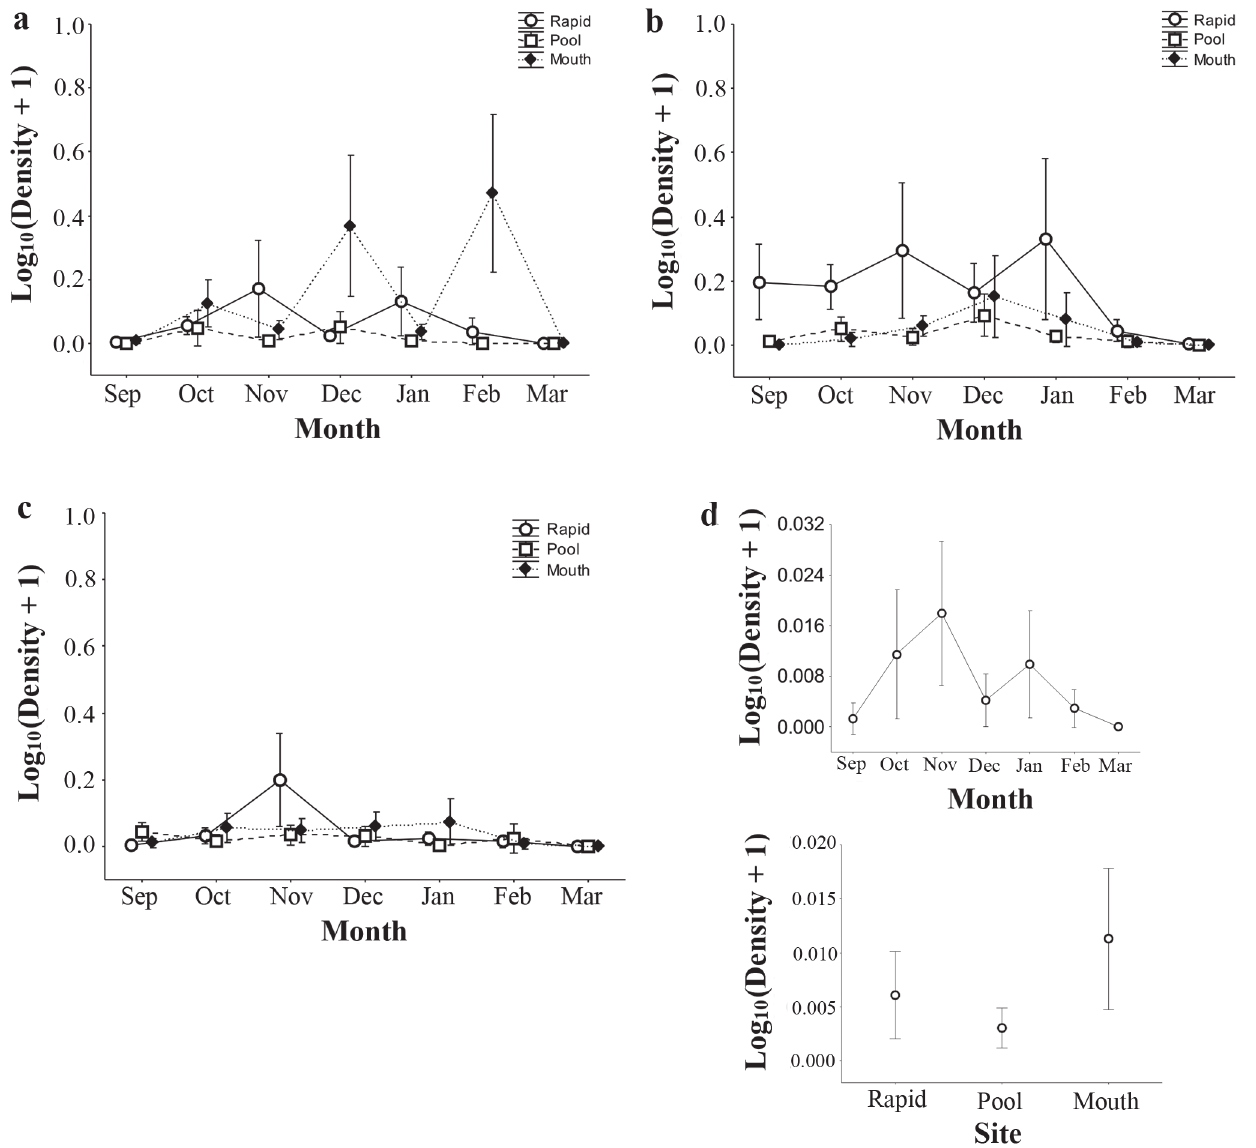
Fig. 5. Average densities (± standard error) of the different larval stages of the samples obtained from three locations of the Ligeiro River, between the months of September 2006 and March 2007: larval yolk ( a ), preflexion ( b ), flexion ( c ), and postflexion ( d